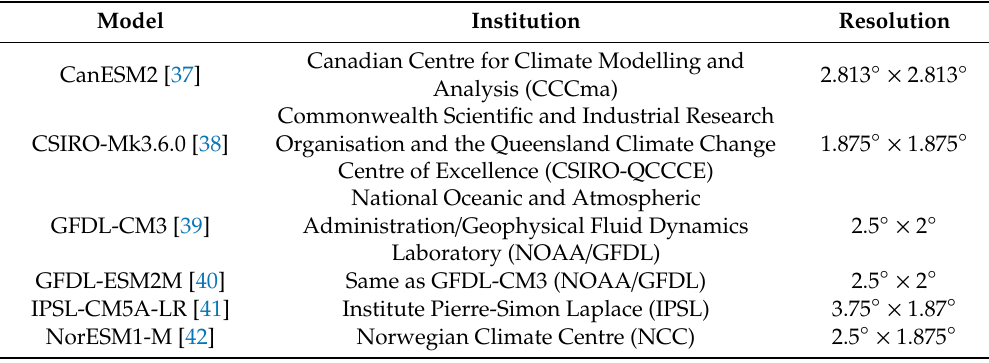
Table 1. The descriptions of the CMIP5 models used in this